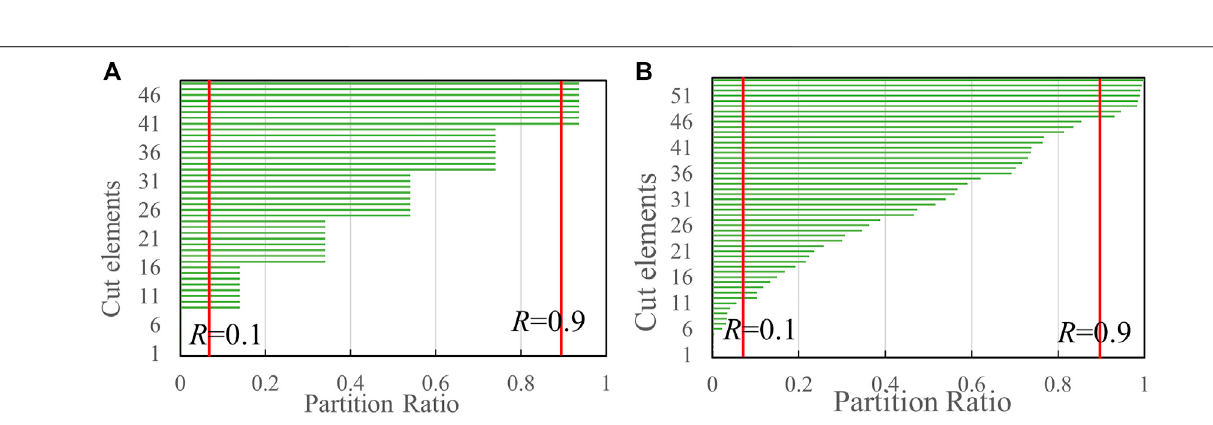
TABLE 3 | Condition numbers of Jacobian matrix with different penalty